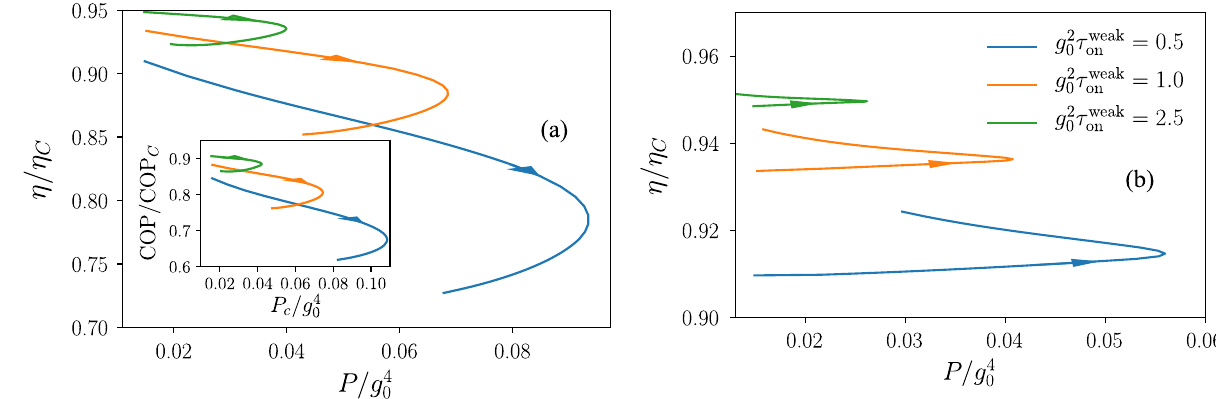
FIG. 13. Efficiency versus power for the quantum Carnot cycle depicted in Fig. 12. Each curve shows engine performance for a fixed value of τ weak and τ weak and various values of k ∈ ½ 1 ; 8 (cid:2) , with arrows indicating increasing k . The switching on and off of the interaction on iso k τ weak k 2 τ weak is scaled differently in the two plots, with (a) τ and (b) τ . Parameters are ½ ε 1 ; ε 2 ; ε 3 ; ε 4 (cid:2) ¼ ½ 1 ; 0 . 5 ; 1 . 5 ; 3 (cid:2) , on ¼ on ¼ on on g 2 0 = ε 1 ¼ 0 . 1 , g 2 0 τ weak ¼ 50 , ð β c ε 1 Þ − 1 ¼ 1 . 1 , ð β h ε 1 Þ − 1 ¼ 2 . 2 , and Λ = ε 1 ¼ 100 . The inset of (a) shows a near-identical refrigerator iso performance characteristic for the reverse